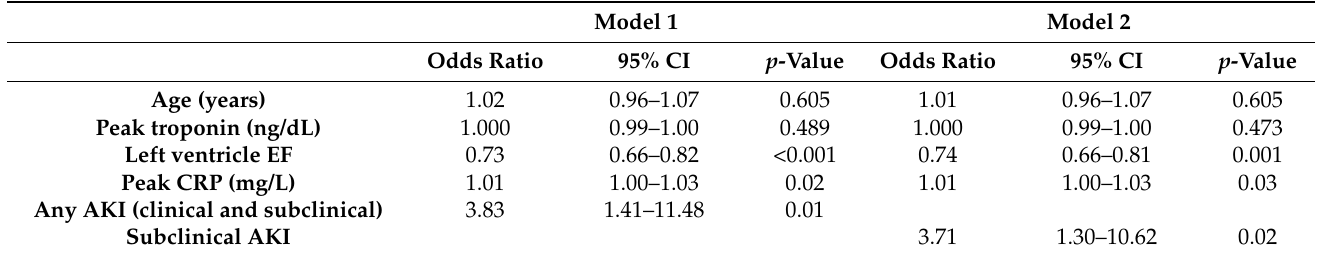
Table 3. Multivariate logistic regression model for predictors of in-hospital major adverse